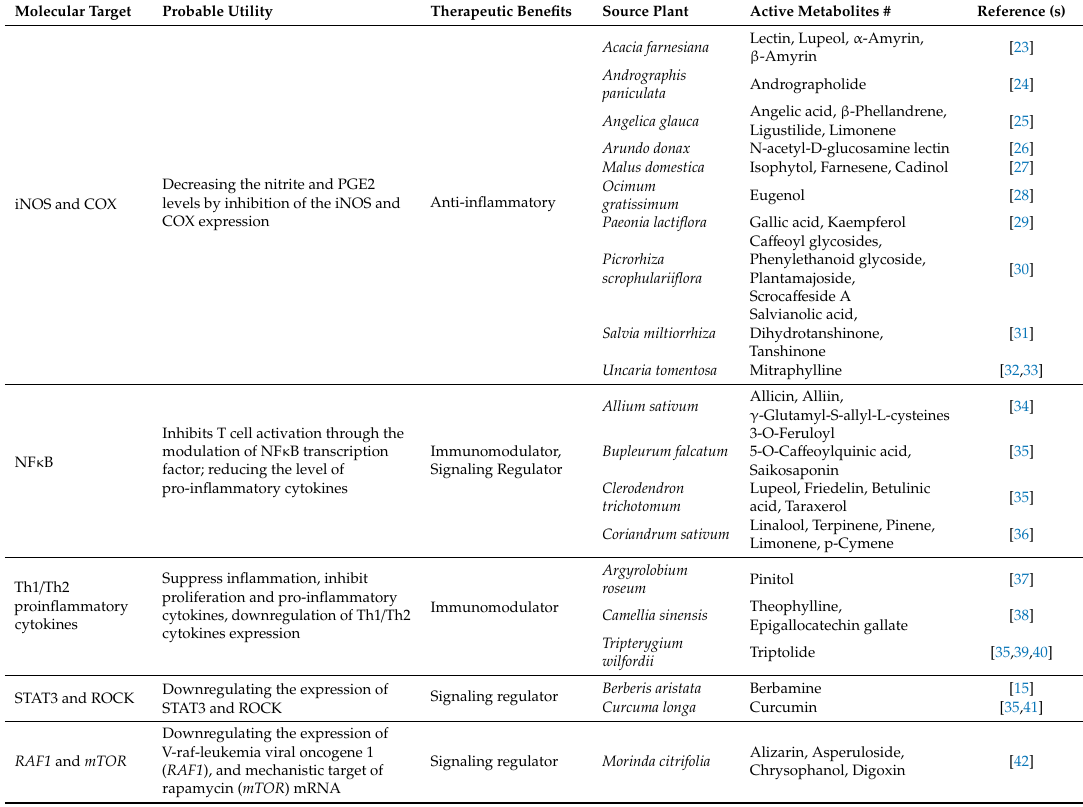
Table 1. Major phyto-metabolites along with their targeted utility as therapeutic potentials for systemic lupus